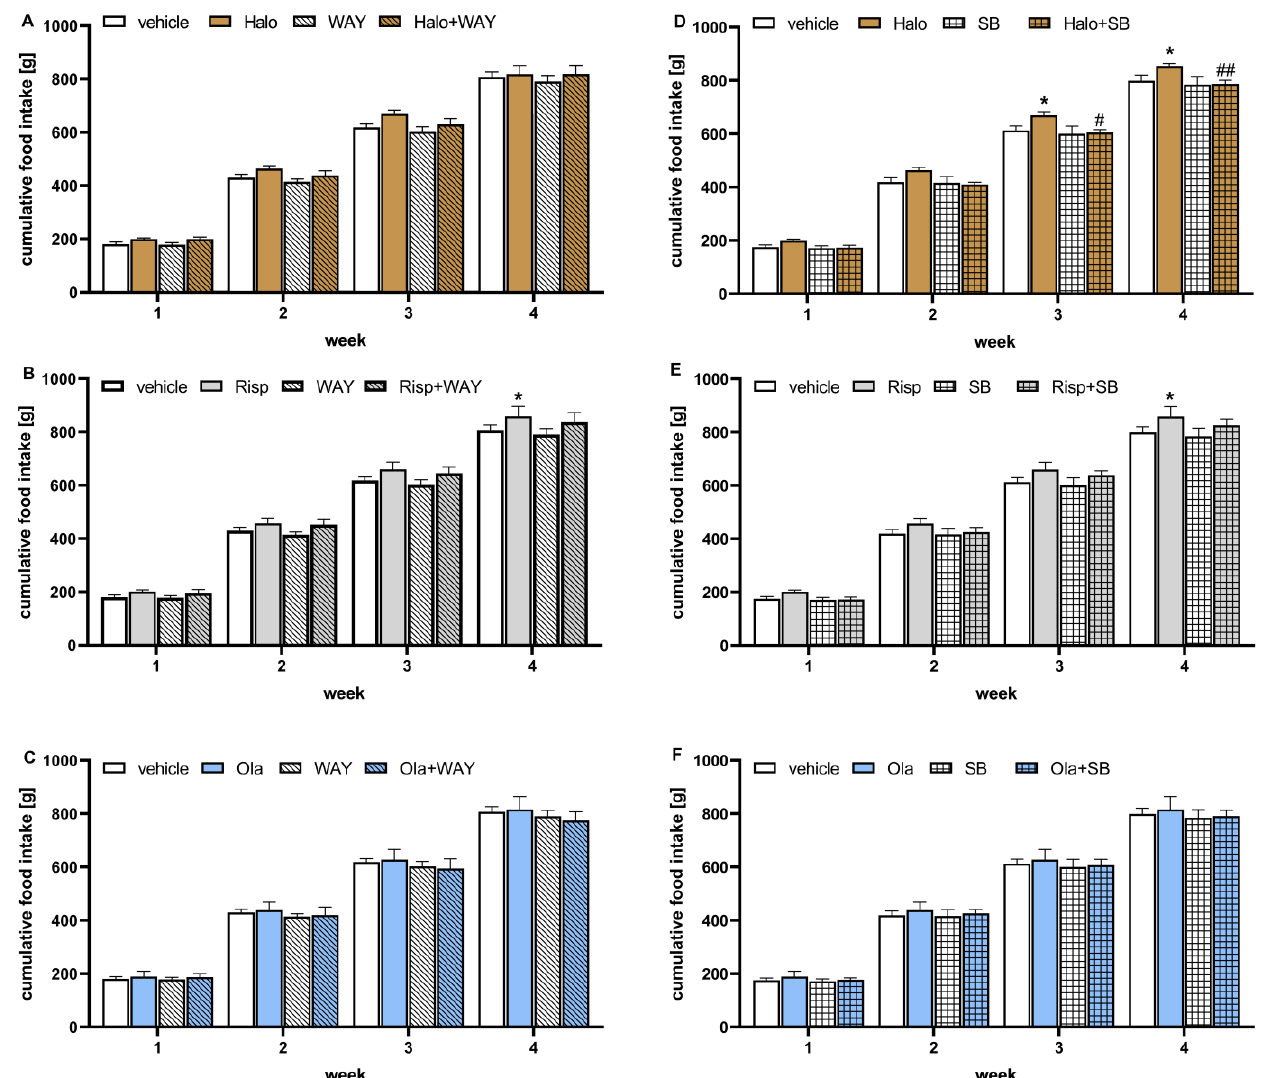
Figure 3. Effects of haloperidol, risperidone, olanzapine, WAY-181187 ( A – C ) and SB-742457 ( D – F ), given alone and in combinations, on cumulative food intake in rats. The results are presented as mean ± SEM ; n = 9 – 10. * p < 0.05 versus respective vehicle-treated group; # p < 0.05, ## p < 0.01 versus the respective APD-treated group (two-way repeated measures of ANOVA followed by Bonferroni’s post hoc test). Halo, haloperidol 0.5 mg/kg; Risp, risperidone 0.5 mg/kg; Ola, olanzapine 5 mg/kg; WAY, WAY-181187 3 mg/kg; SB, SB-742457 3 mg/kg.